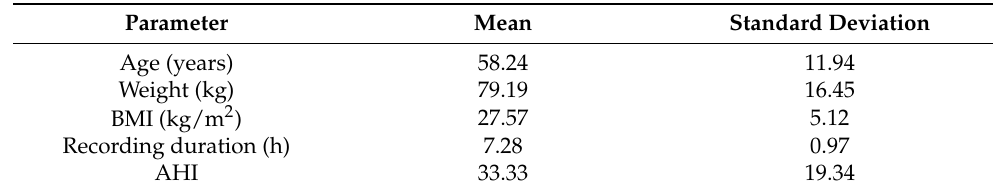
Table 1. Summary of the used part of SHHS-1 dataset.